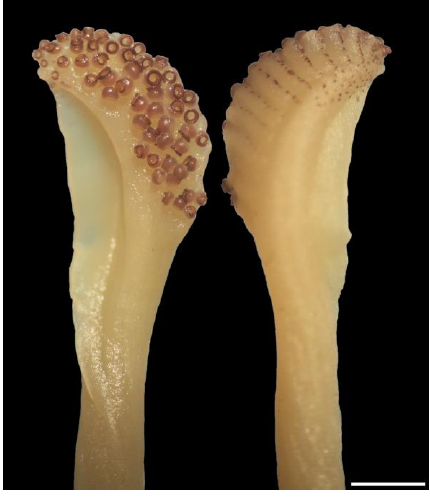
Figure 12. Dorsal ( left ) and ventral ( right ) views of left tentacle and club of Sepia typica (SAIAB 211554, male ML 21 mm). Scale bar 1 mm. The arms are robust, stout, and relatively long (Figure 13), with the length varying formula, but the tendency is for arms to be subequal in females (Table A3), and for IV p. > I p. in males (Table A2). The ventral arms are keeled. There is a strong membrane joining arms for about 40–50% of their length; it is absent between arms IV p. Protective mem- branes are well developed.